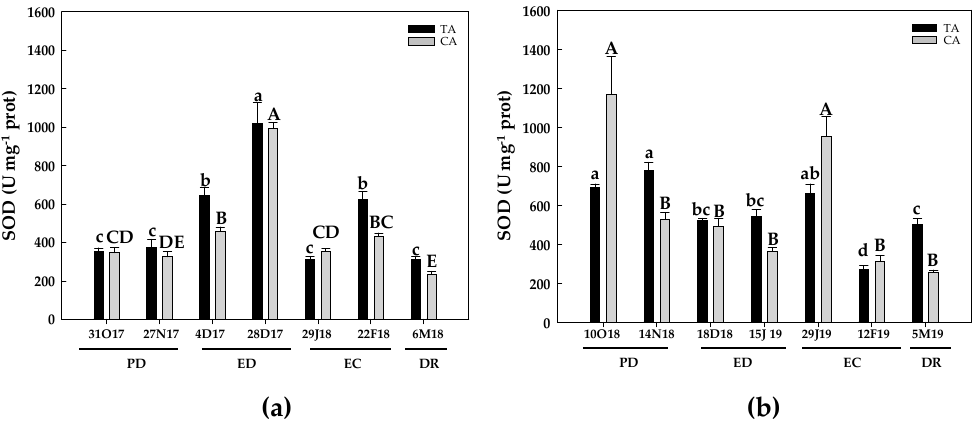
Figure 11. Evolution of superoxide dismutase (SOD) activity in flower buds of peach ‘GEM020’ cultivated in two different geographical areas during the dormancy cycle on two seasons. ( a ): season 1 (2017–2018); ( b ): season 2 (2018–2019). Data represent the mean ± SE, n = 5. Different letters (lowercase and uppercase for the samples of the temperate (TA) and the cold area (CA), respectively) indicate significant differences according to Tukey’s multiple test ( p ≤ 0.05). PD: paradormancy; ED: endodormancy; EC: ecodormancy; DR: dormancy release. FW: fresh weight. The chill units accumulated at the different times and locations are shown in Supplemental file 1.